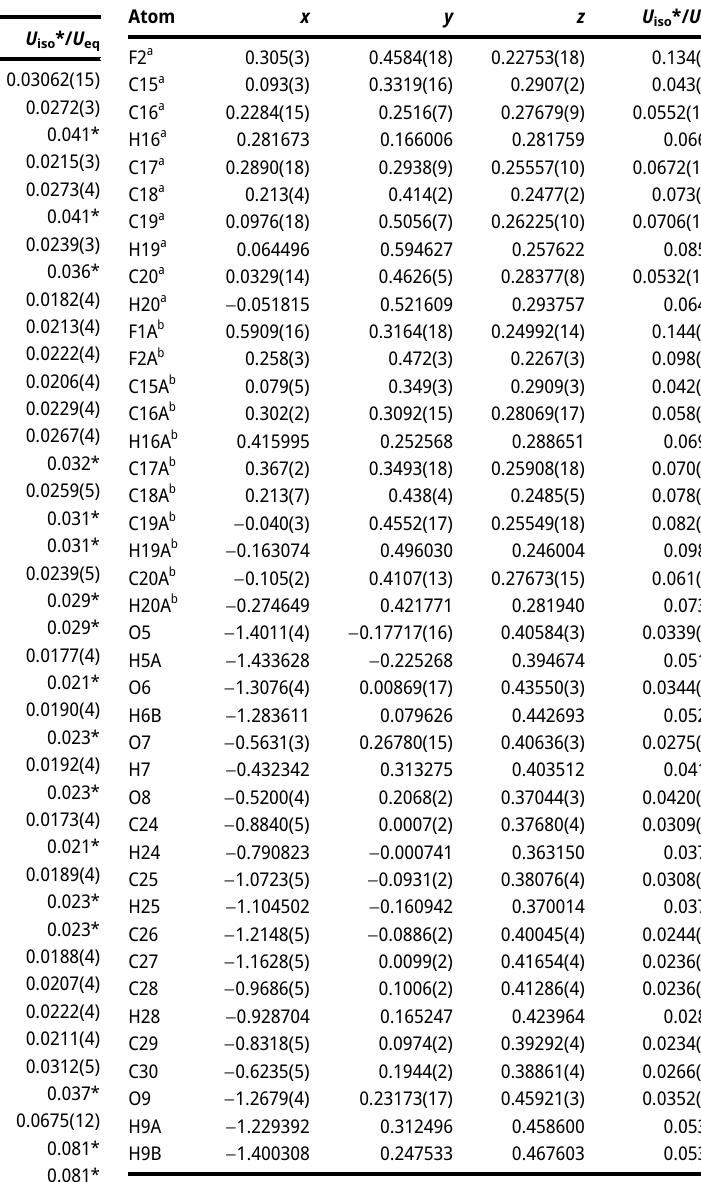
Table  : Fractional atomic coordinates and isotropic or equivalent isotropic displacement parameters (Å 